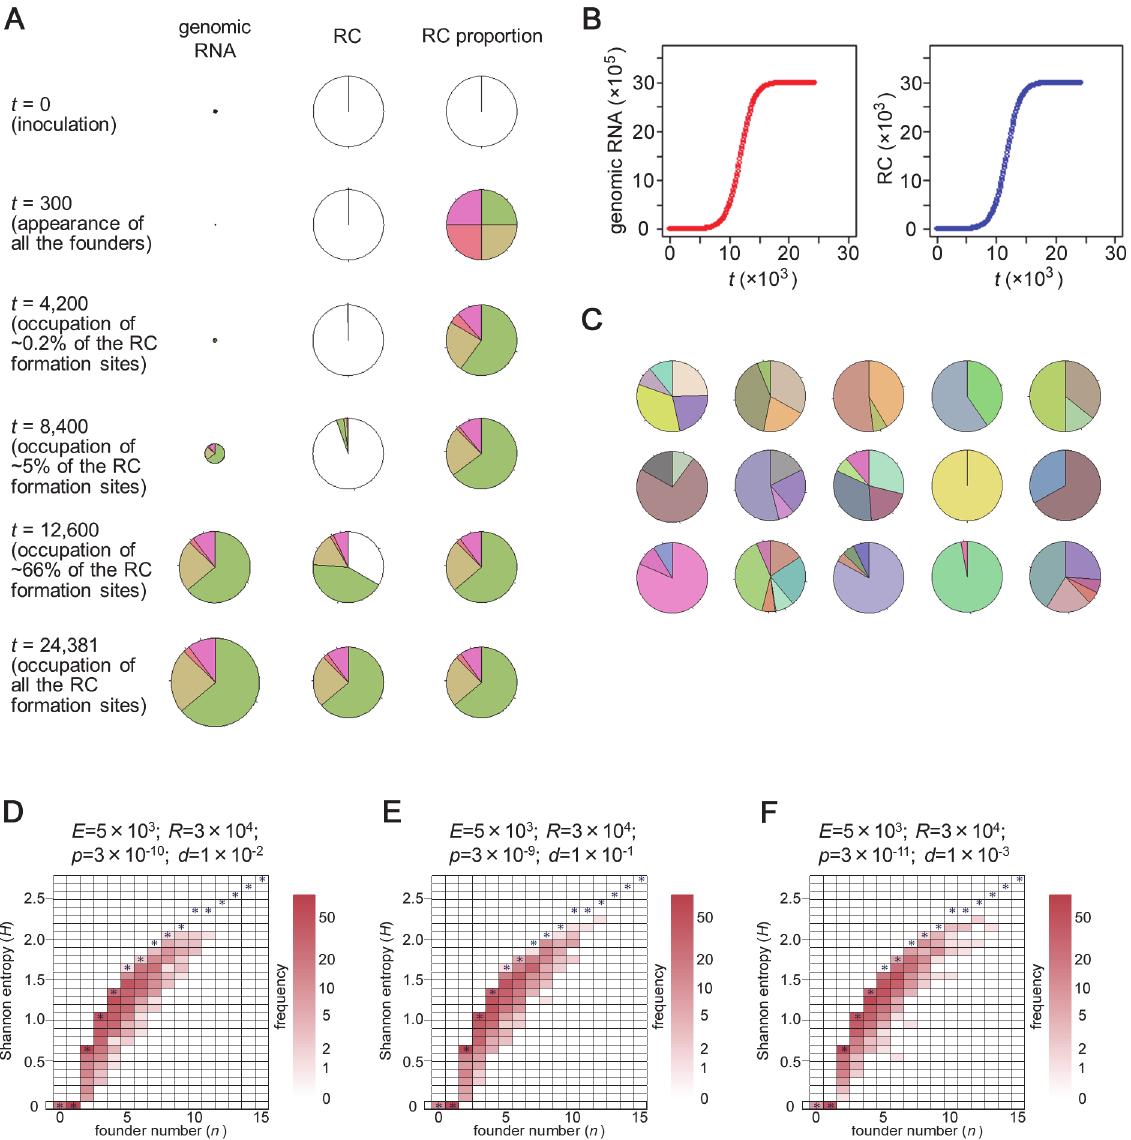
Fig 3. Simulation results for single-cell infections. (A) An example of simulated changes over time in the accumulation of genomic RNA and RC site occupancy in single-cell infections. Simulations were performed using the following parameters: E = 5 × 10 3 , R = 3 × 10 4 , p = 3 × 10 – 10 , and d = 1 × 10 – 2 . t indicates the time units that passed from the start of the simulation. Pie charts show the number of genomic RNAs, number of RCs, and proportion of RCs that originated from each founder. Note that the pie charts for number of RCs (middle) include empty sites for RC formation (indicated in white), whereas those for RC proportion (right) do not. For the number of genomic RNAs, the total amount in each time point is shown by an area of the pie chart. (B) The accumulation of total genomic RNA (left) and RCs (right) of the simulation shown in (A). (C) Examples of the simulated accumulation of progenies in 15 cells. The color codes were assigned automatically according to the identification number (from 1 to 5,000) of the founders. (D – F) Simulated founder numbers and progeny accumulations in 1,000-cell infections. The results are summarized in two-dimensional histograms, with founder number on the x -axis and Shannon entropy on the y -axis. The theoretically maximum Shannon entropy (i.e., the entropy in the case of equal accumulation) for each founder number belongs to each bin indicated by an asterisk. The parameter values used for the simulations are shown above each histogram. An R script used to generate panels A, B, and C is shown in S1 Text. To generate panels D, E, and F, an R script shown in S3 Text was used, and the data obtained by the authors are shown in S2